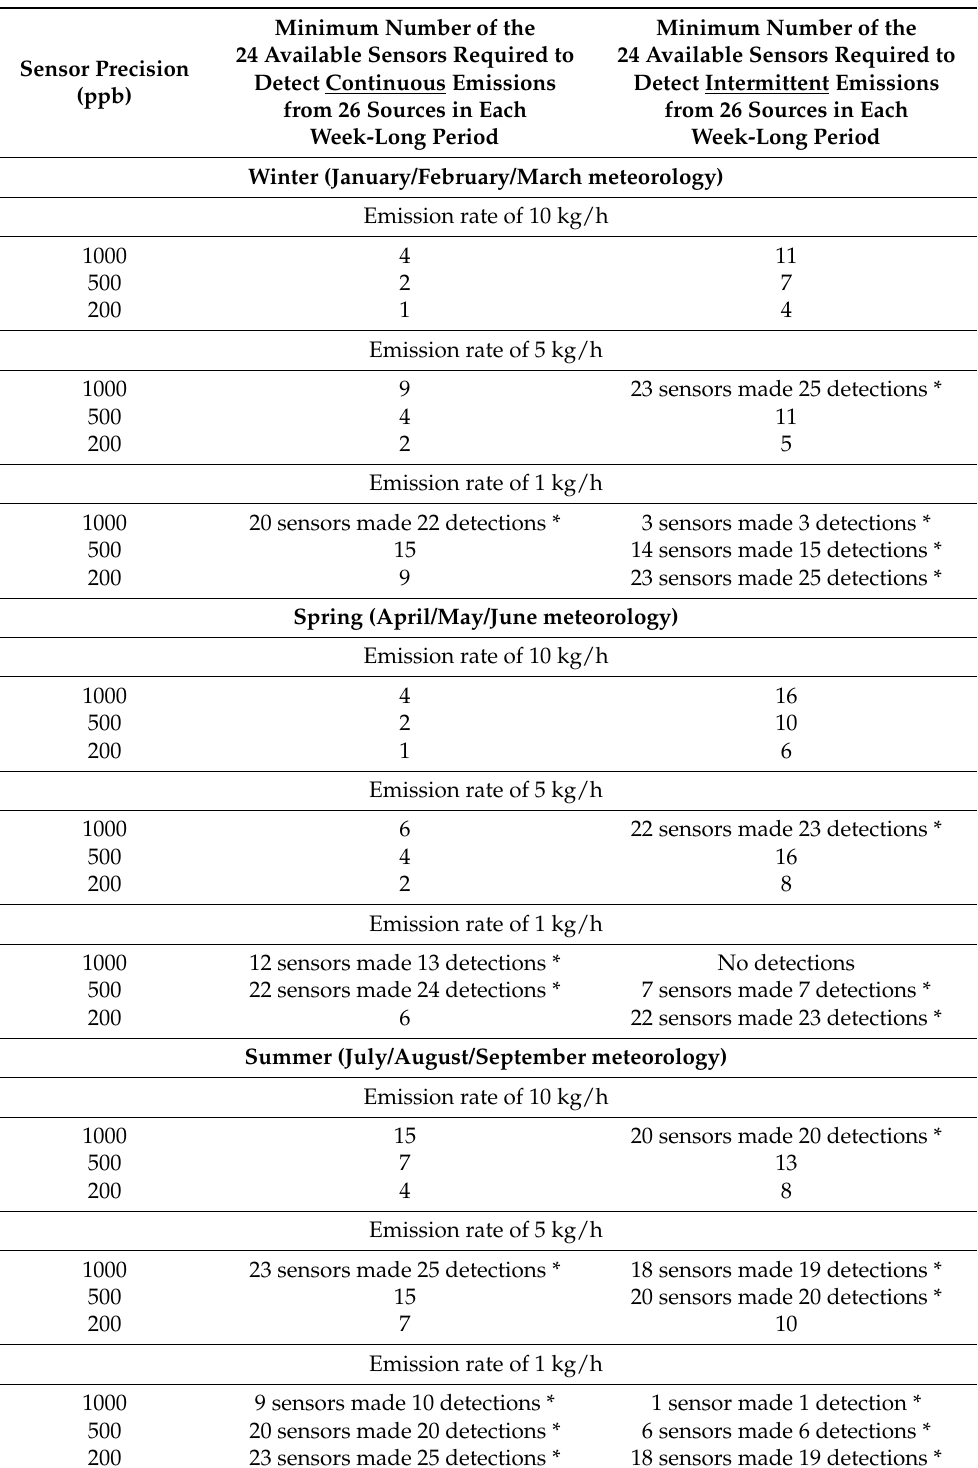
Table 3. Sensors required to detect continuous and intermittent emissions from each of the 26 emissions sites, for the weeks representing winter, spring, summer, and fall meteorology (26 detections in each